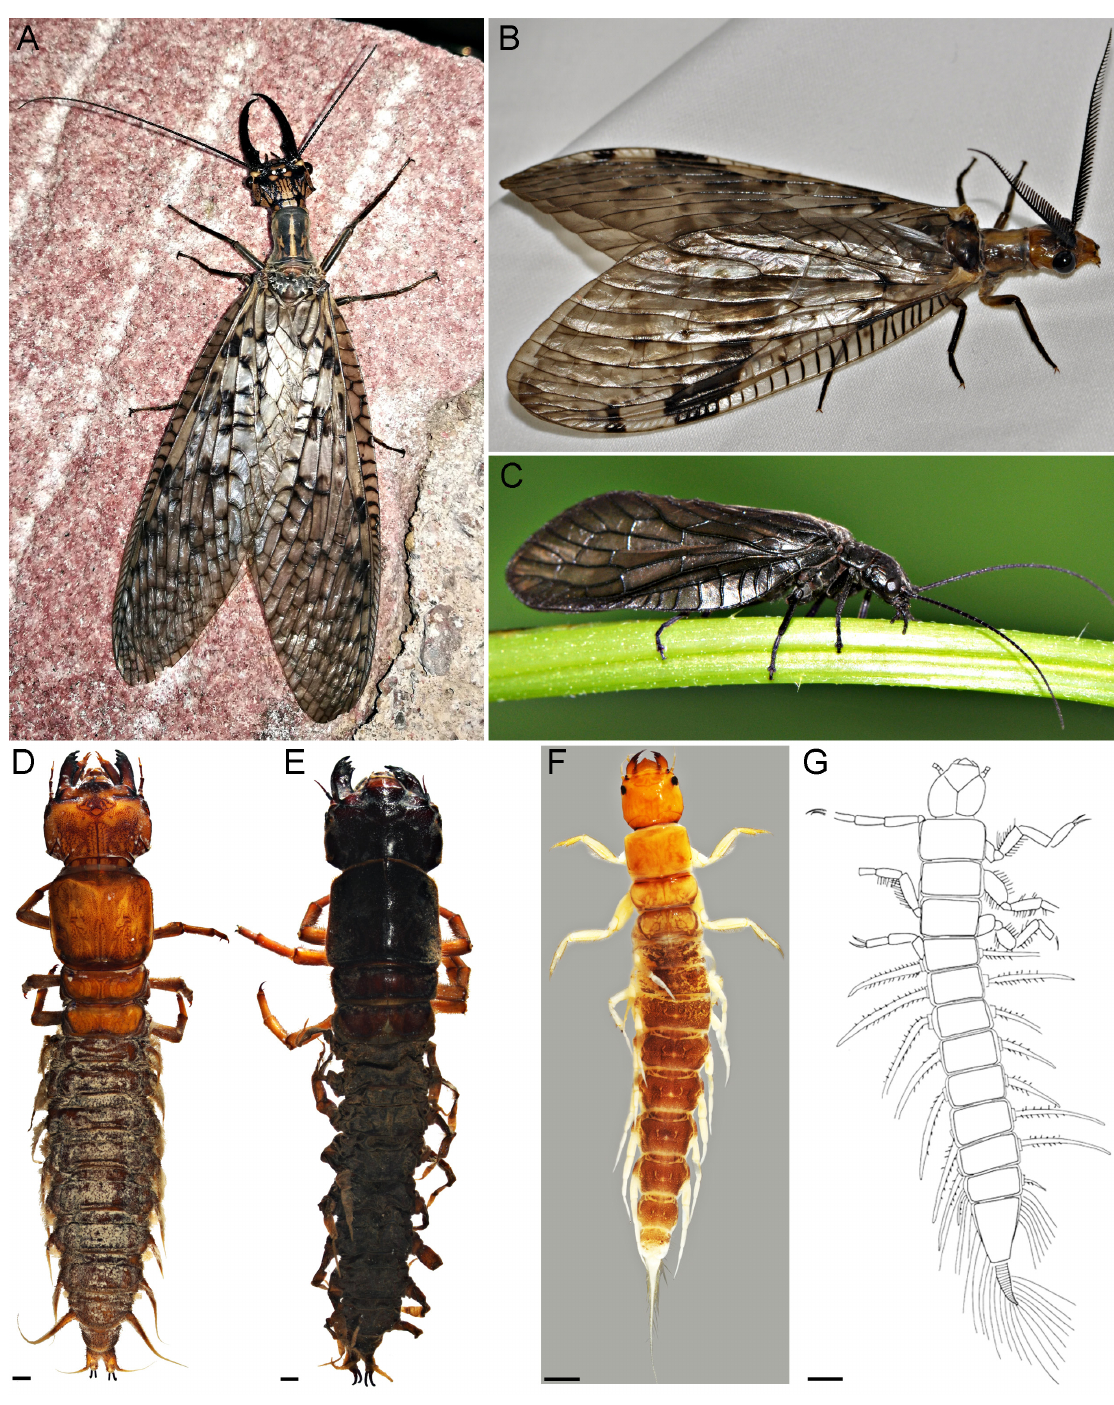
Fig. 1. Representative habitus illustrations of megalopteran families and subfamilies. A–C . Adults. A . Acantha-corydalis orientalis (McLachlan, 1899) (Corydalidae: Corydalinae). B . Neochauliodes fraternus (McLachlan, 1869) (Corydalidae: Chauliodinae). C . Sialis sibirica McLachlan, 1872 (Sialidae: Sialinae). D–G . Larvae. D . Corydalus luteus (Hagen, 1861) (Corydalidae: Corydalinae). E . Orohermes crepusculus (Chandler, 1954) (Corydalidae: Chauliodinae). F . Sialis sp. (Sialidae: Sialinae). G . † Sharasialis fusiformis Ponomarenko, 2012 (Sialidae: †Sharasialinae) (after Ponomarenko 2012). Scale bars = 1 mm. Photos A–C by © Xingyue Liu; D–F by © Caleb C.